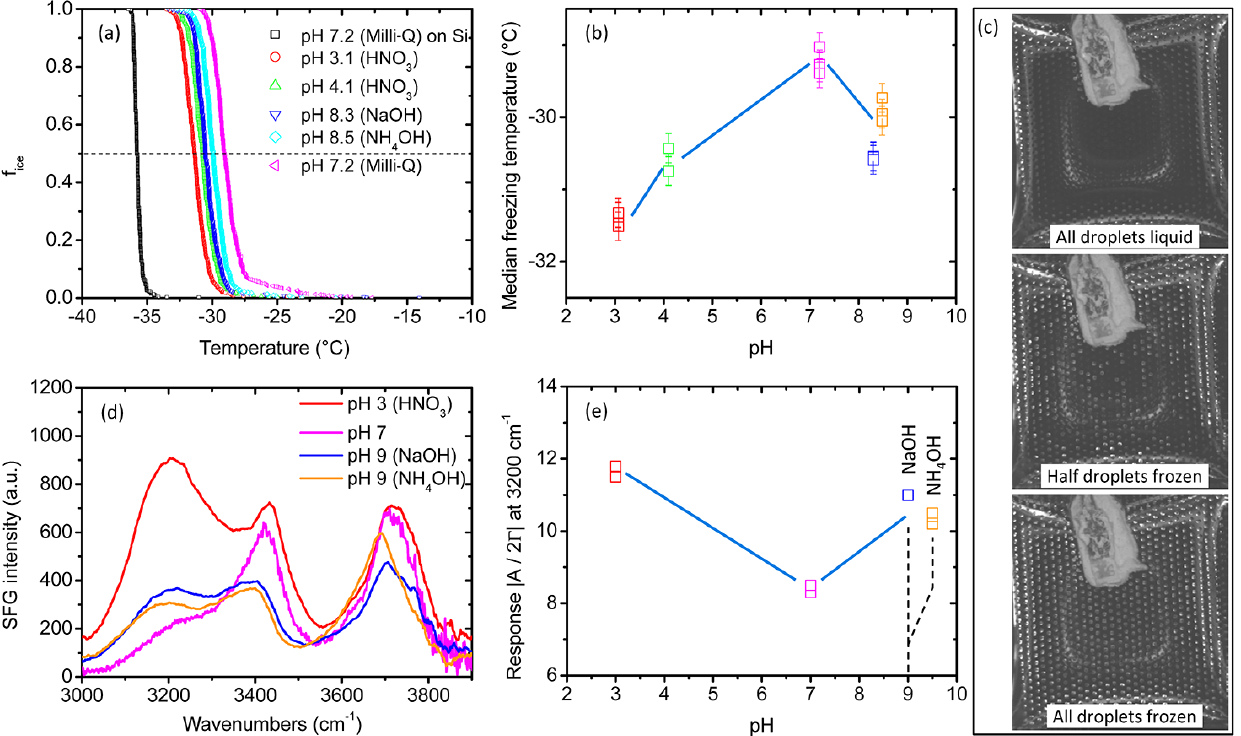
Figure 2. (a) Fraction of frozen droplets as a function of temperature of sapphire (0001) surface in contact with different pH solutions. The black curve shows the data for water on a silicon substrate. (b) Freezing temperature as a function of pH of the different solutions for three independent experiments. (c) Images of typical droplets on the substrate at different stages of the droplet-freezing assay experiment. (d) SFG spectra of liquid water at the sapphire (0001) surface, right before the nucleation event (see text for details); for fits, see Fig. 3. (e) Absolute value of the amplitude divided by width as a function of pH for the 3200cm − 1 resonance inferred from the data shown in (d) . Different data points indicate data obtained from freshly prepared surfaces, recorded on different